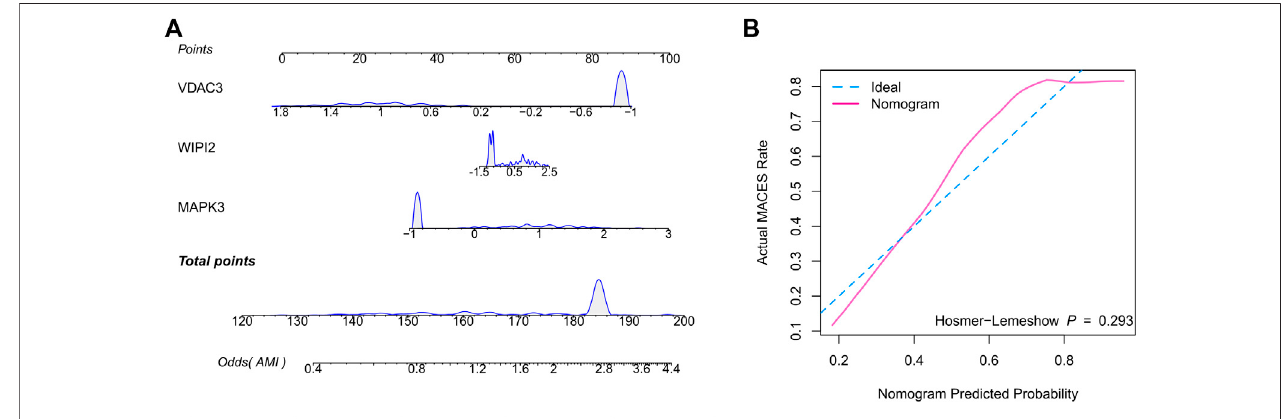
FIGURE 5 | Construction of the nomogram based on the logistic regression model. (A) Nomogram speci fi cally quanti fi ed the odds ratio of AMI based on 3 ferroptosis characteristics. (B) The calibration curves of